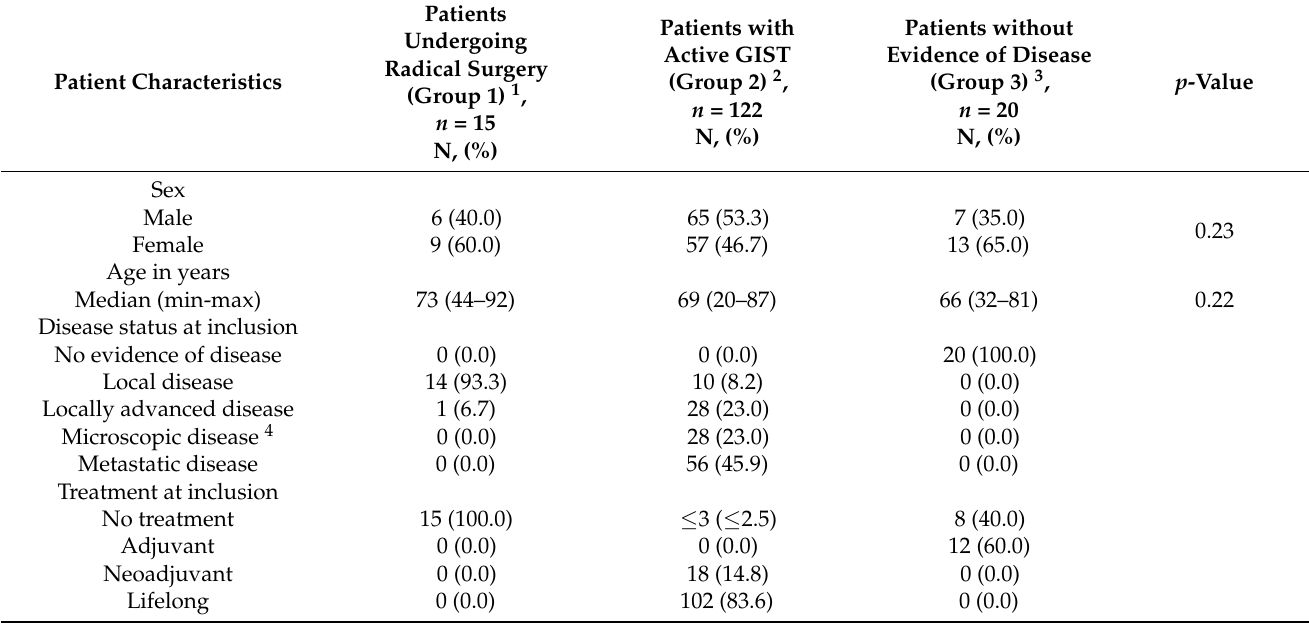
Table 1. Patient and disease characteristics at the time of inclusion for patients undergoing radical surgery (group 1), patients with GIST (group 2), and patients without evidence of disease (group